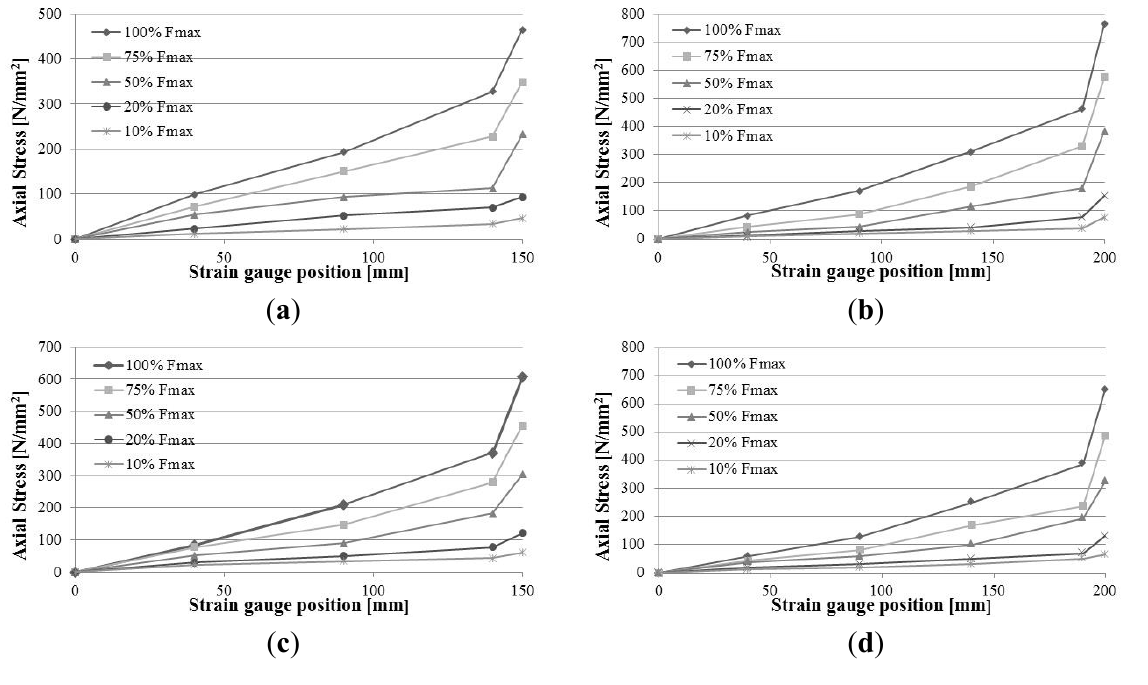
Figure 12. Normal stress versus position: ( a ) SF_2 test; ( b ) SF_4 test; ( c ) SC_2 test; ( d )